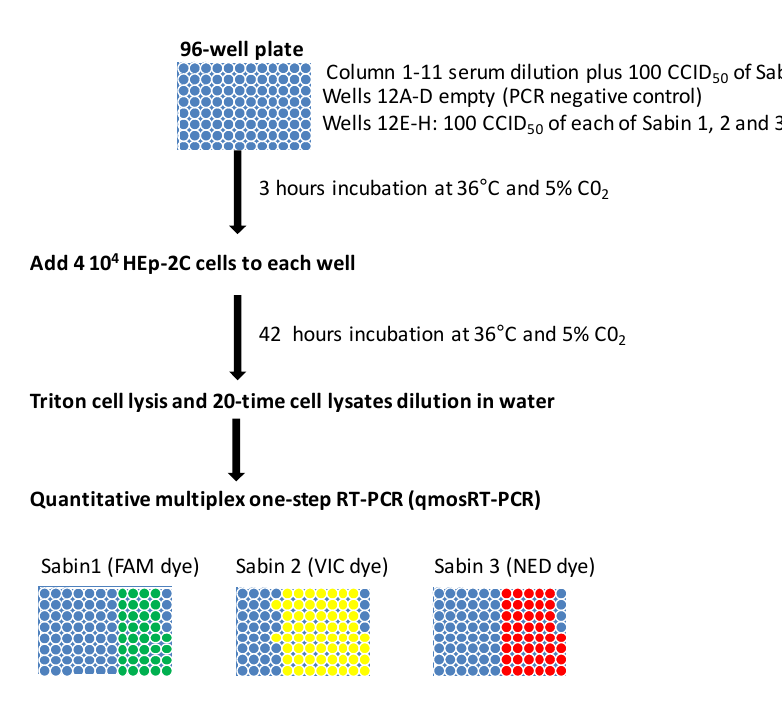
Figure 3. Multiplex PCR-based neutralization (MPBN) assay layout.